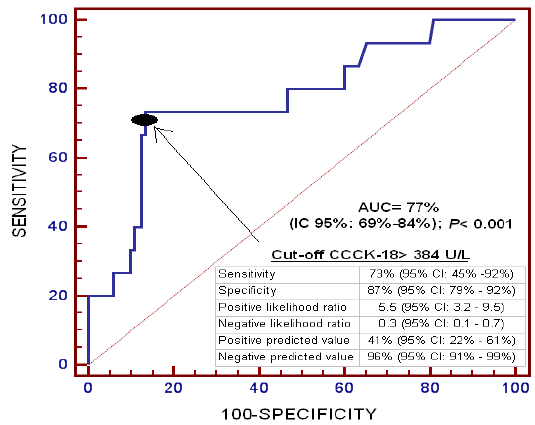
Figure 1. Receiver operating characteristic curve of serum caspase-cleaved cytokeratin (CCCK)-18 levels to predict mortality at one year in patients undergoing liver transplantation for hepatocellular carcinoma.